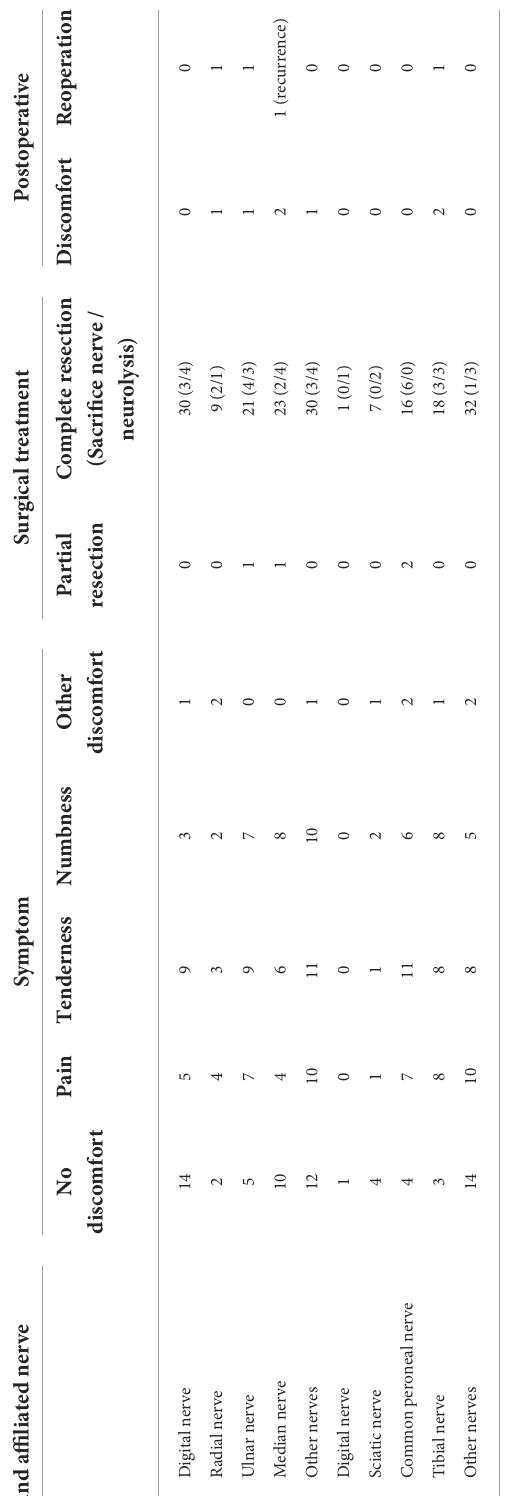
immunohistochemistry due to good postoperative functional recovery, did not have further clarification of the tumor